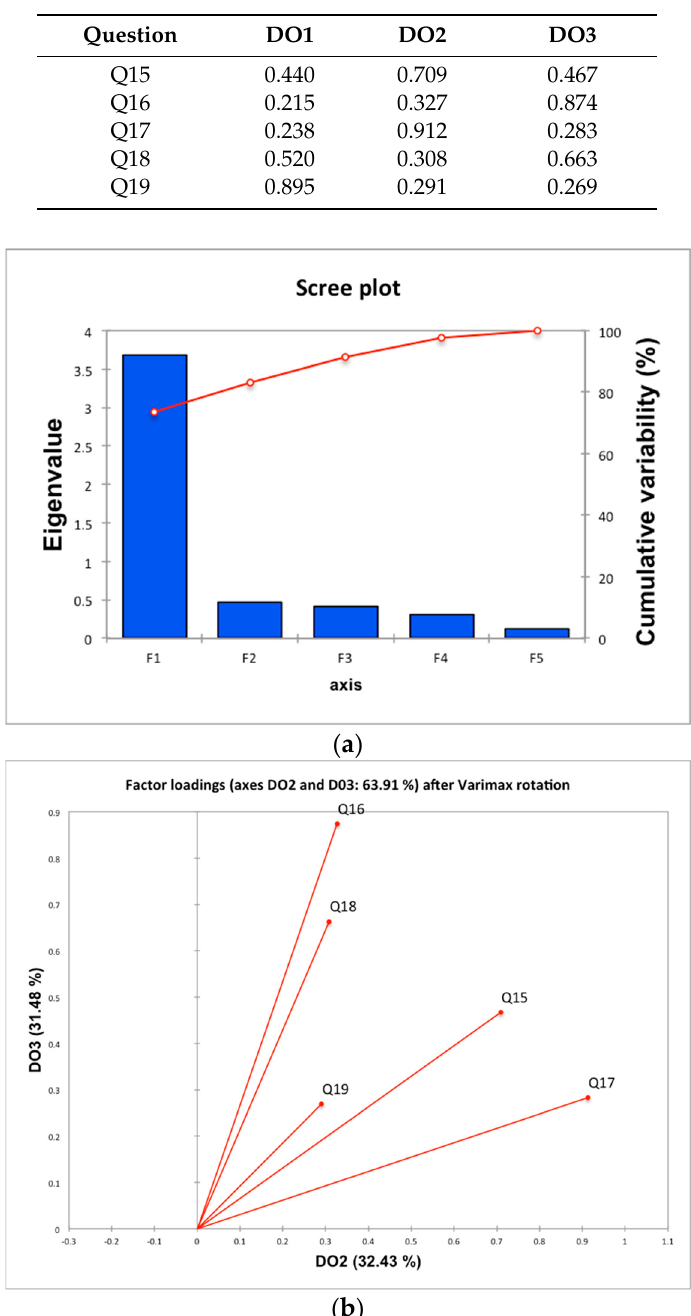
Figure 5. Factor analysis: Students’ opinions regarding the use of BIM and the skills acquired during the second implementation phase. ( a ) Scree plot; ( b ) factor loadings after varimax rotation.